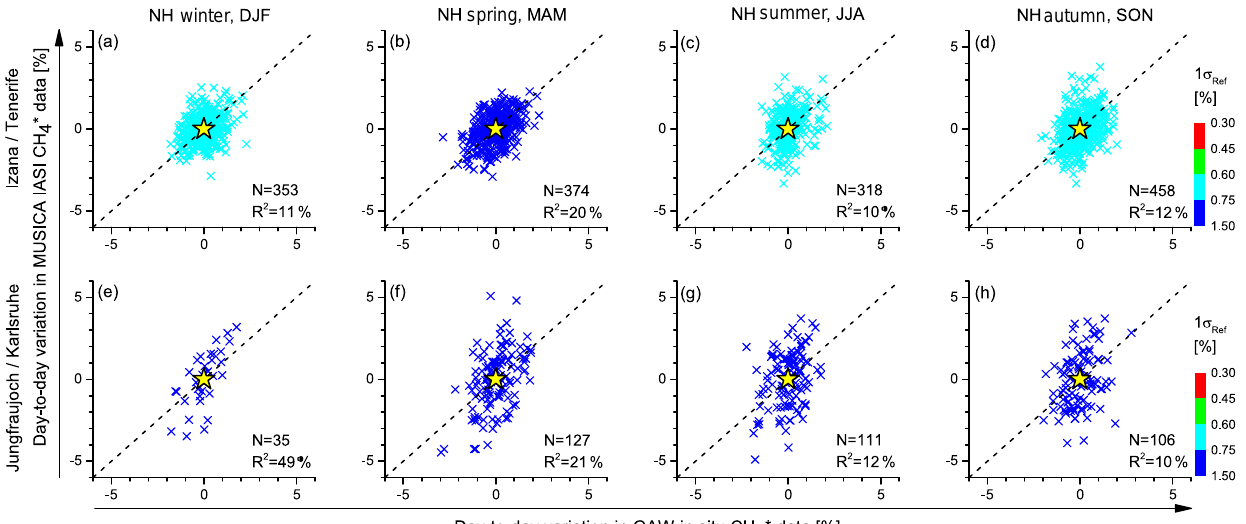
Figure 20. Correlation plots for intra-month day-to-day variations in CH ∗ (MUSICA IASI 4.2km retrieval products versus GAW high- 4 mountain observatory in situ data): (a–d) for the surroundings of Tenerife Island; (e–h) for the surroundings of Karlsruhe; (a) and (e) for northern hemispheric winter; (b) and (f) for spring; (c) and (g) for summer; and (d) and (h) for autumn. The colour code indicates the 1 σ scatter in the GAW references (1 σ Ref ) during the considered season, the yellow star represents the a priori data used for the retrievals and the black dashed line is the one-to-one diagonal. Number of considered days ( N ) and R 2 values are given in each panel (all correlations are positive and significant on the 95% confidence